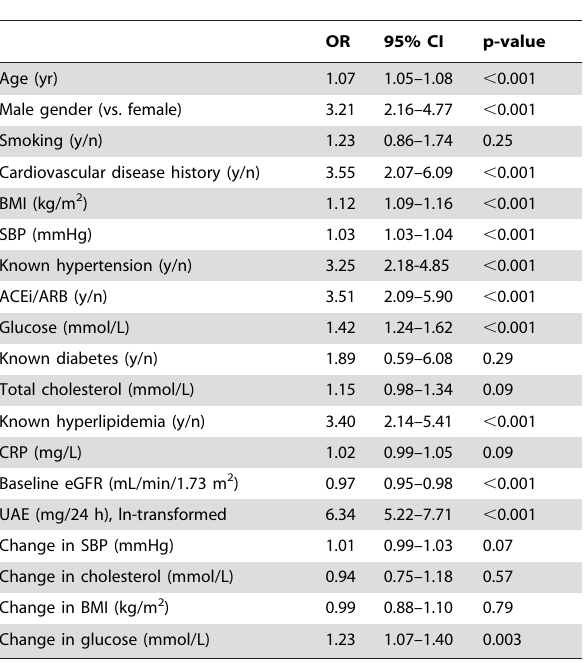
Table 2. Results of univariable logistic regression analyses exploring subject characteristics associated with progressive